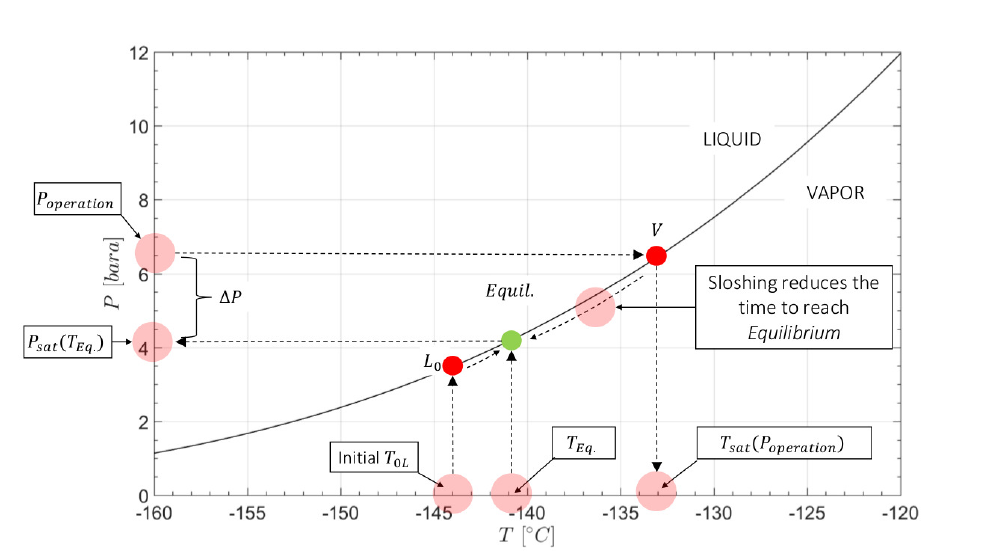
Figure 1. Co-existence curve for methane. The liquid acts as an internal energy sink to the system. Thermal equilibrium results in lower tank pressure. Sloshing reduces the time to reach the final state. The p-T data was generated using REFPROP v9.1